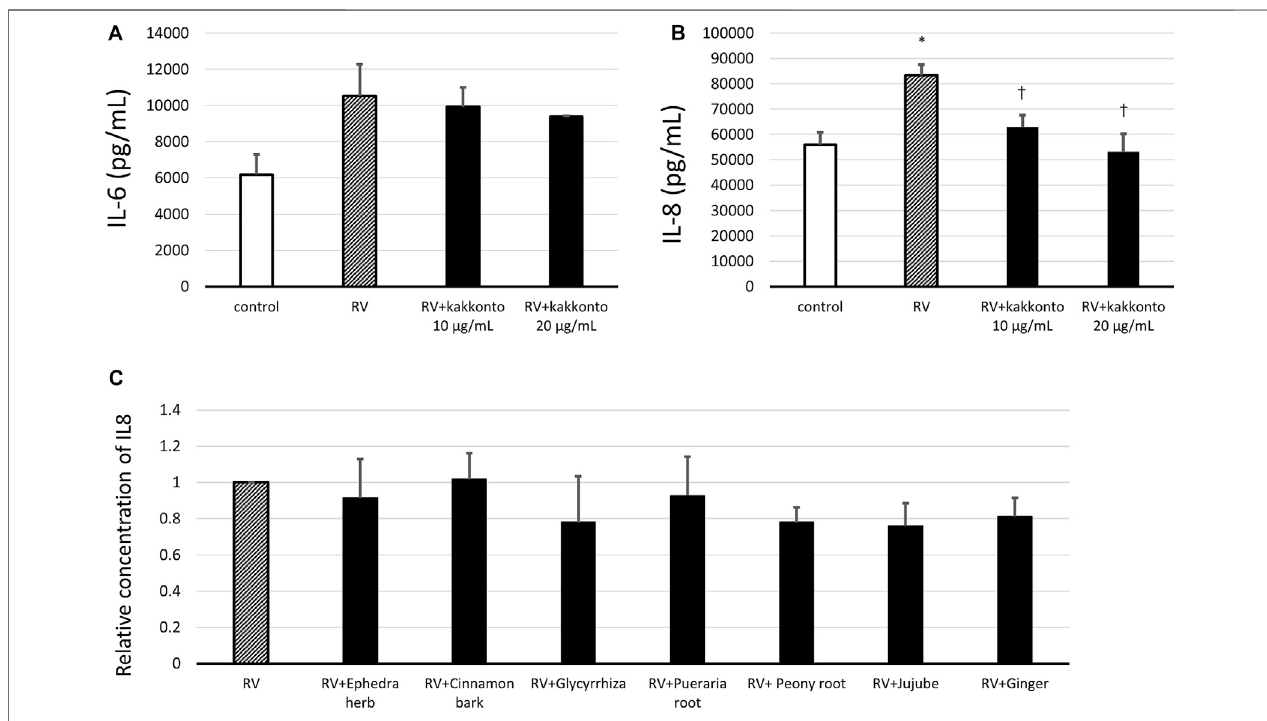
FIGURE6|(A,B) ReleaseofIL-6 (A) andIL-8 (B) intoculturesupernatants24 hafterRV14infectioninthepresenceof10 μ g/mlor20 μ g/mlkakkonto,orafterculturing inmediumalone (RV) ormockinfection (control).* p < 0.05signi fi cant differences comparedtocontrolcells inthe absence ofRVinfection (control); (B) . † p < 0.05signi fi cant differencescomparedtoRVinfectionalone(RV). (C) RelativeabundanceofIL-8releasedinculturesupernatants24 hafterRV14infectioninthepresenceofeachcrudedrug of the kakkonto extract. Results are expressed as the relative amount (%) compared to cells cultured in medium alone (RV) and are presented as the mean ± SE from three (A,B) and seven (C) HNE cultures. The concentration of each crude drug was calculated as the weight % of 20 μ g/ml kakkonto extract.